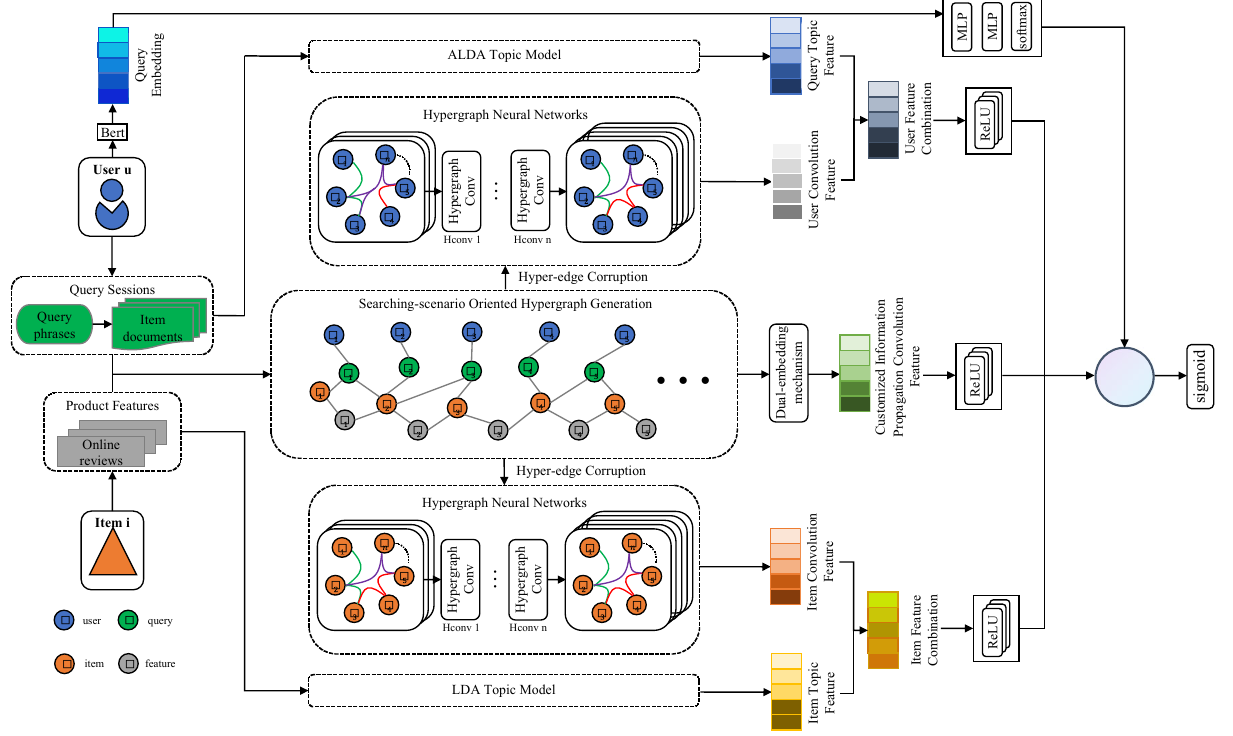
Figure 1. The proposed topic augmented hypergraph neural network (Topic ‐ HGNN) framework for searching ‐ scenario oriented recommendation.